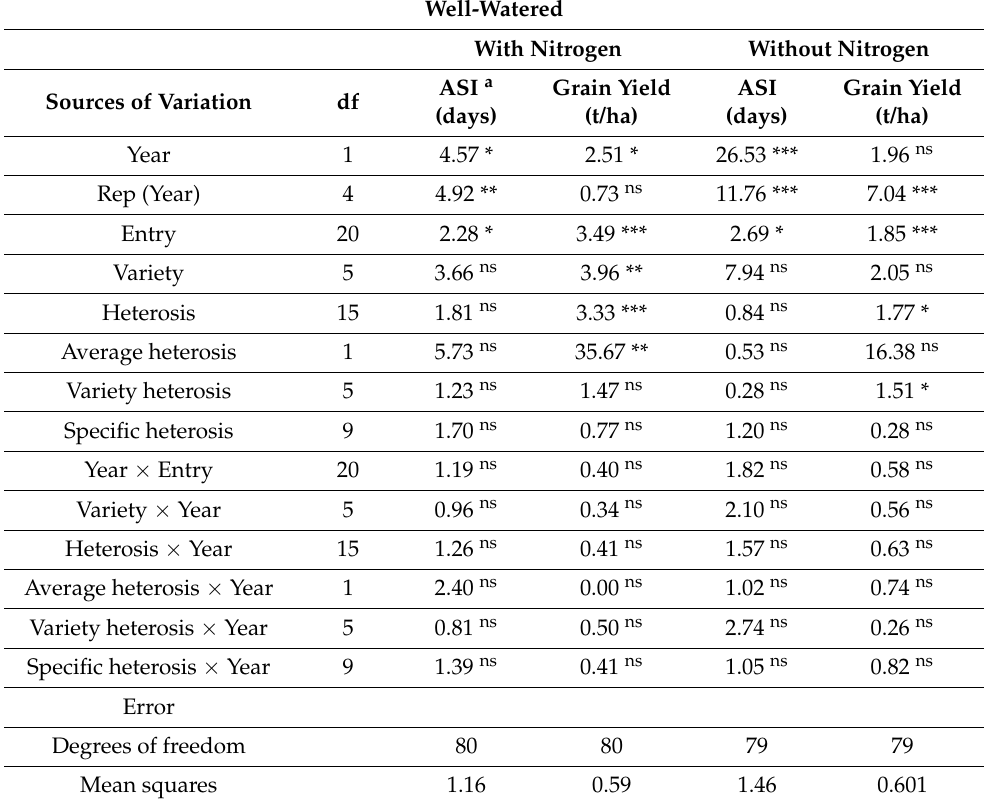
Table 2. Mean squares of ASI and grain yield from the Analysis II of Gardner and Eberhart [42] of the diallel made with six Algerian maize populations evaluated, along with four checks in two years, in Algiers, under drought and nitrogen